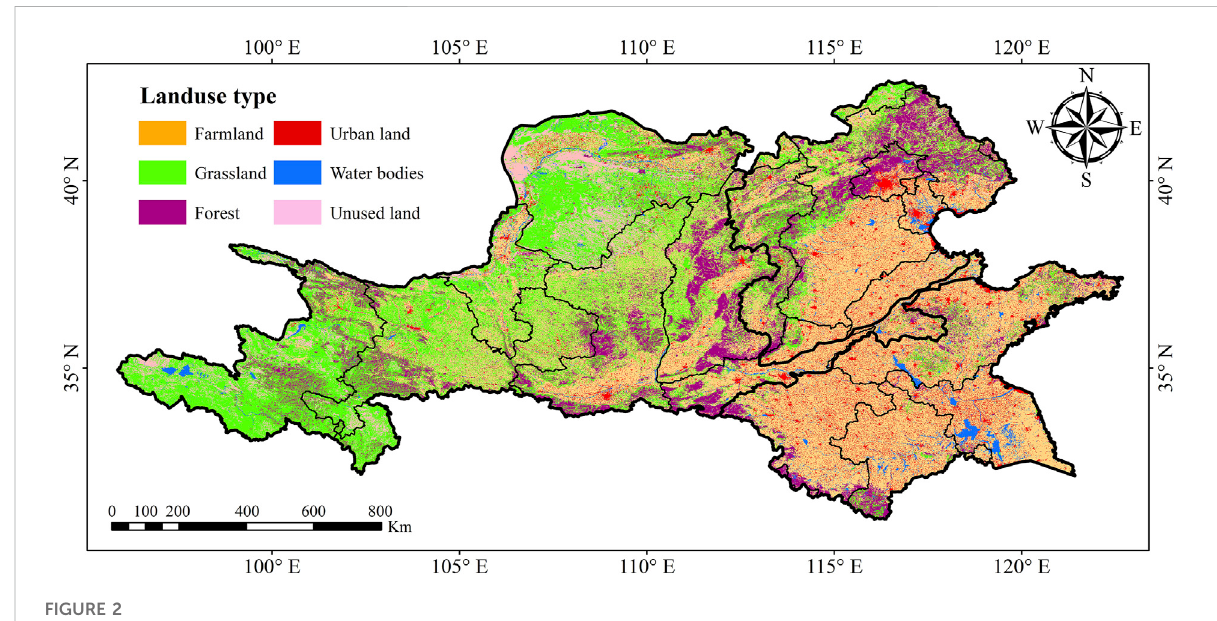
FIGURE 2 Distribution of land use types in the YHHRB in